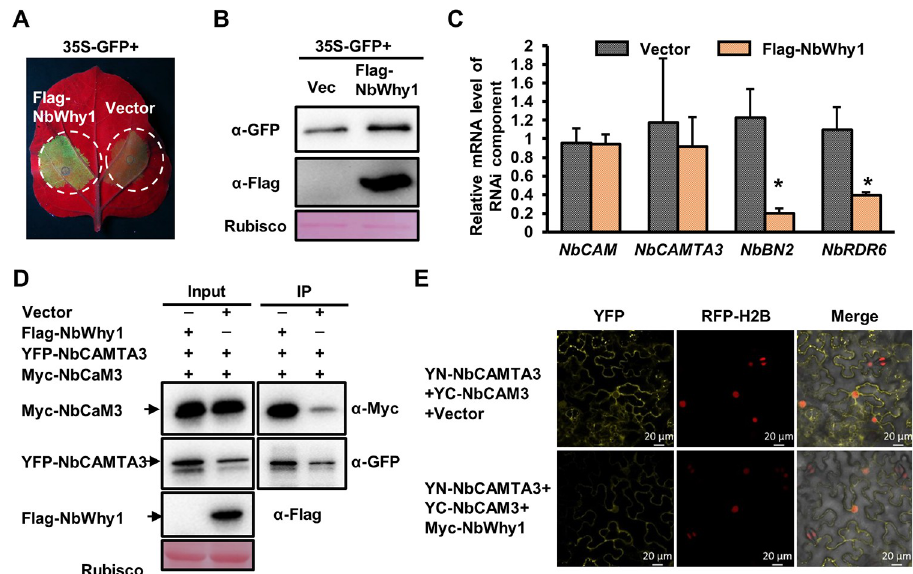
Fig 5. NbWhy1 impairs RNAi and interferes with NbCaM3-NbCAMTA3 interaction. (A) GFP fluorescence in the leaf patches of N . benthamiana infiltrated with 35S-GFP+Flag-NbWhy1 or 35S-GFP+pCambia-Flag. Infiltrated leaves were photographed under UV light at 3 dpi. (B) Western blot analysis of GFP accumulation and expression of Nbwhy1 in the infiltrated patches of (A) using the anti-GFP and anti-Flag antibodies, respectively. Rubisco staining was used as the loading control. (C) qRT-PCR analysis of the mRNA level of key RNAi components in N . benthamiana leaves infiltrated with Flag-NbWhy1 or the pCambia-Flag vector at 48 hpi. NbGAPDH was used as an internal control. Mean and standard deviation of three independent plants are shown. Asterisk indicates a significant statistical difference between two treatments at p < 0.05 based on Student’s t test. (D) Co-immunoprecipitation assays showing NbWhy1-mediated attenuation of the interaction between NbCaM3 and NbCAMTA3. N . benthamiana leaves were infiltrated with Agrobacterium cells harboring the constructs, as indicated. Blots with input samples (Input) or immunoprecipitated samples (IP) were detected with anti-GFP, or anti-Flag, or anti-Myc antibodies. Arrows show the expected protein bands. (E) BiFC assays showing the impaired interaction between NbCAM3 and NbCAMTA3 by NbWhy1. Images were captured using a Zeiss LSM 880 confocal laser scanning microscope at 48 hpi. RFP-H2B served as a nuclear marker. Bars represent 20 μ m.